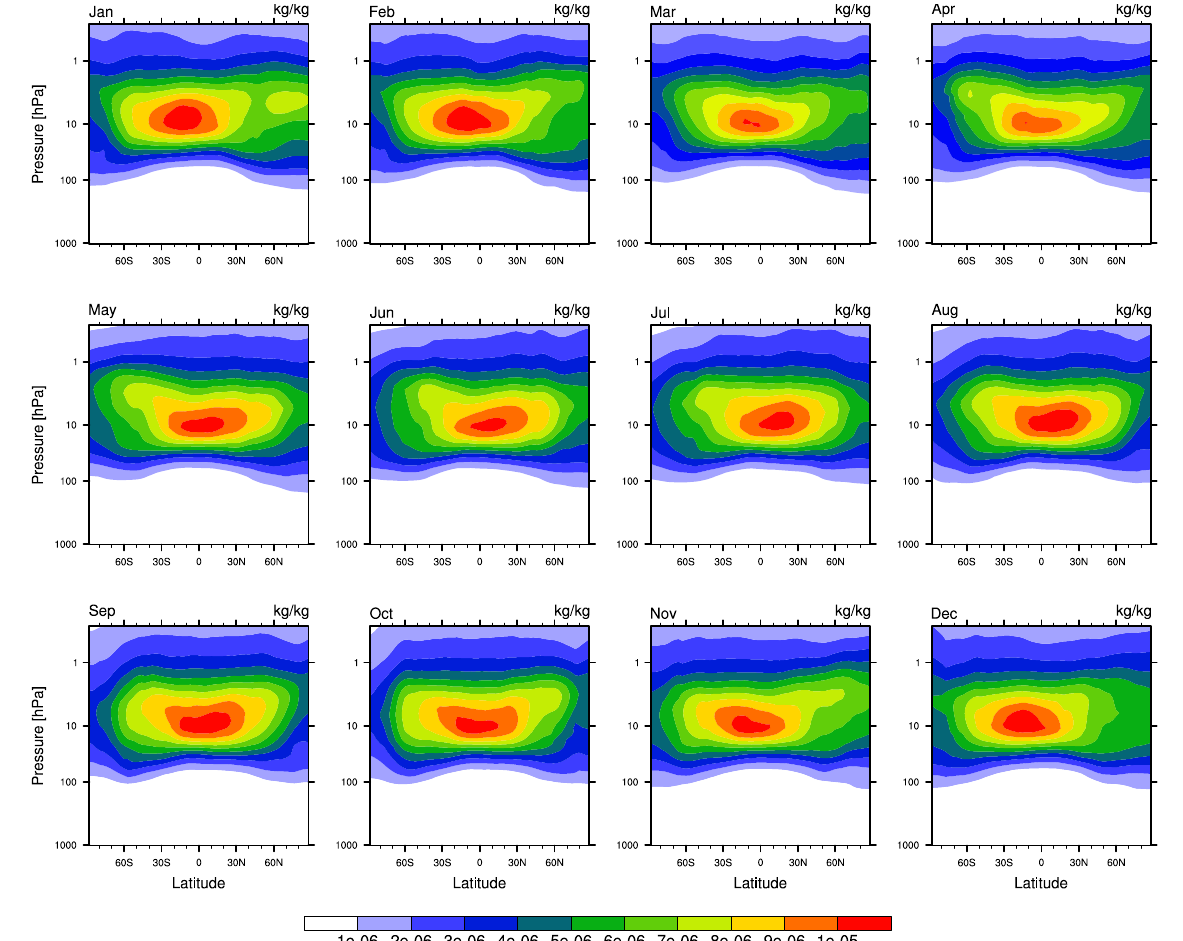
Figure 3. Ozone profile data sets available in